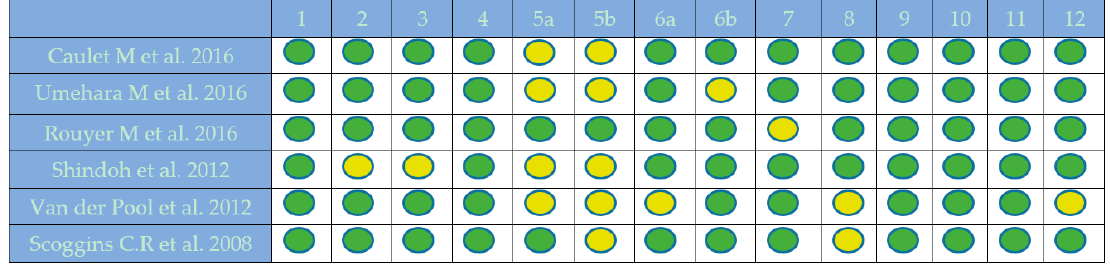
Figure 2. Quality evaluation of cohort studies based on Critical Appraisal Skills Programme (CASP)